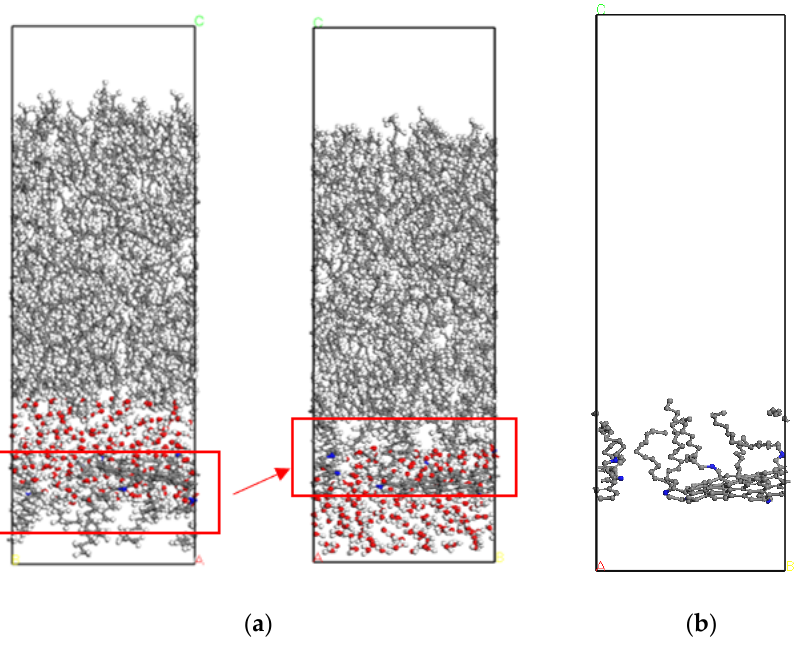
Figure 6. Self-aggregation equilibrium configuration of the system: ( a ) Self-aggregation process, ( b ) self-assembled membrane configuration. ( b ) self-assembled membrane configuration.